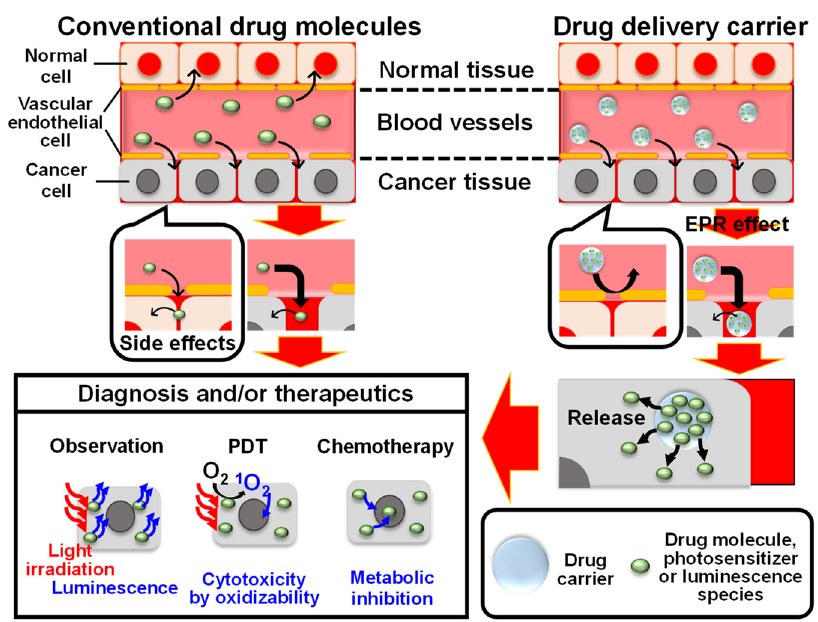
Figure 1. Schematic illustration of the diagnosis with luminescence and therapeutics with chemo- therapy and PDT by conventional drug molecules and drug delivery carrier. apy and PDT by conventional drug molecules and drug delivery